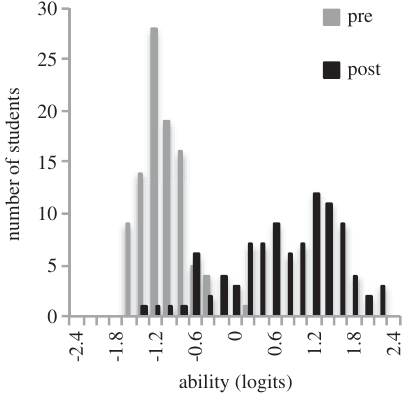
FIG. 15. The pre- and postability histogram for class 1.